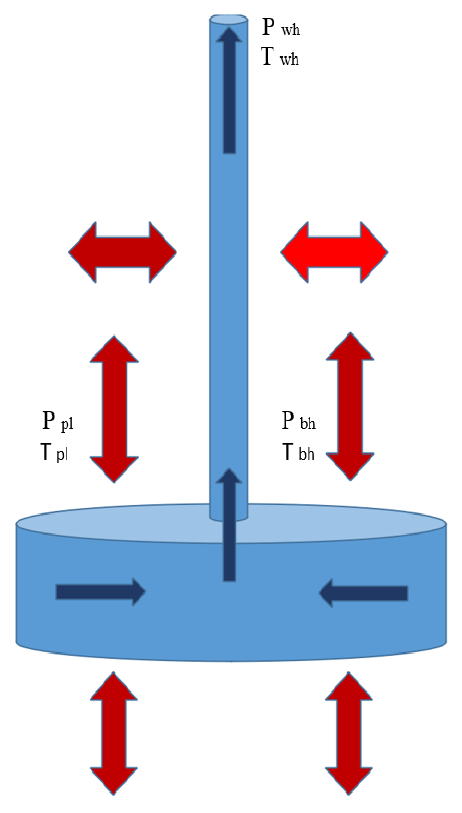
Figure 1. Scheme of motion of the gas condensate mixture and heat exchange with rocks in the system of the reservoir well.